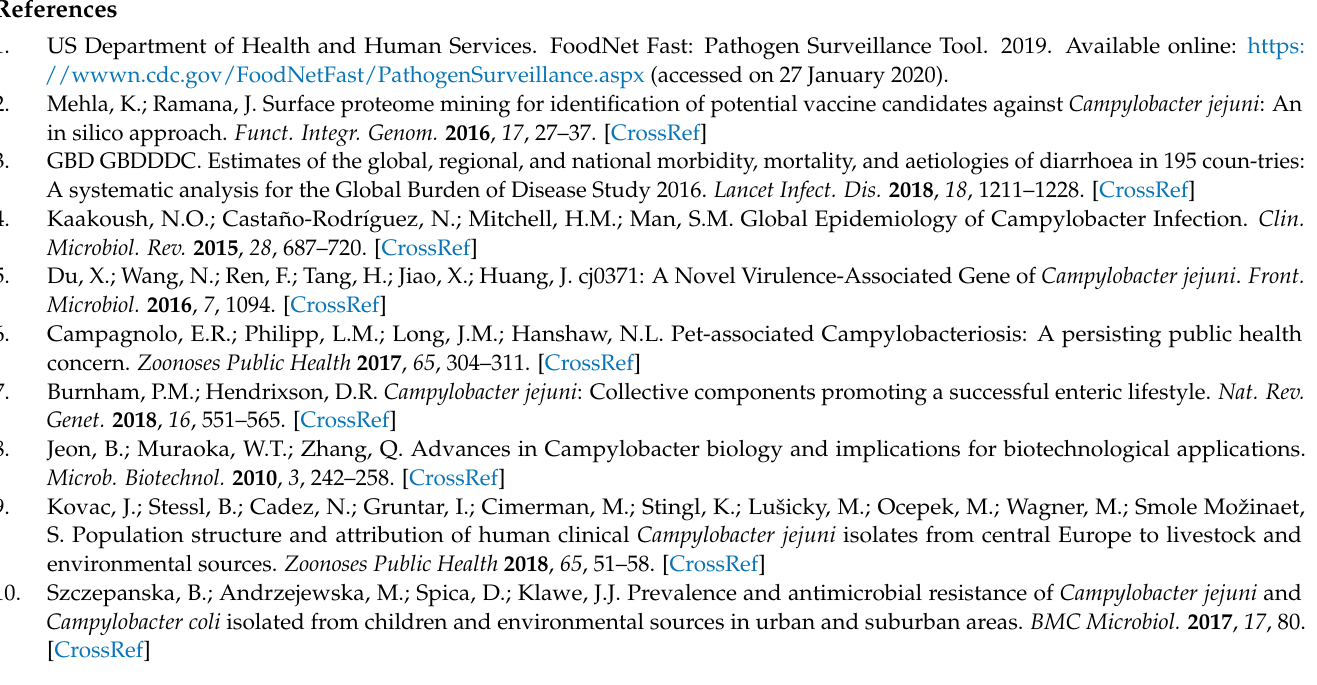
Predicted protein structure of C. jejuni CbrR using the known crystal structure for ortholog Caulobacter crescentus PleD, Figure S3: Replacement of cbrR confirmed by PCR, Table S1: Bacterial strains and plasmids used for this study, Table S2: PCR primers used for this